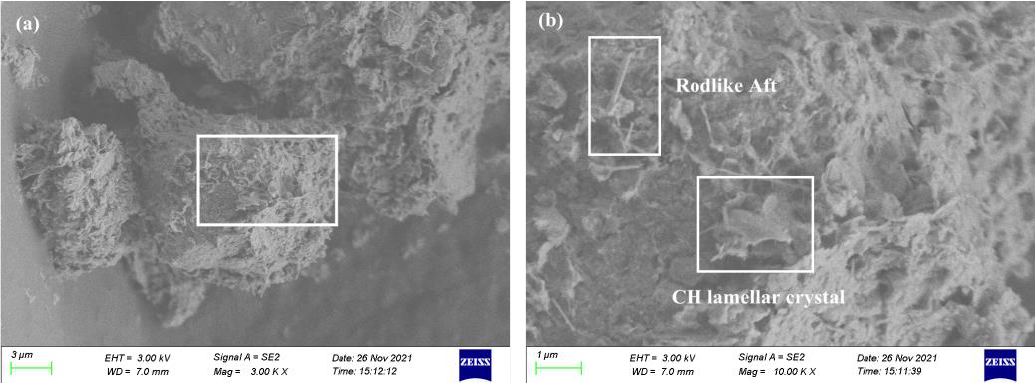
Figure 10. Ordinary-cemented soil cured for 28 d. ( a ) (3.00 kx magnification) and ( b ) (10.00 kx magnification).